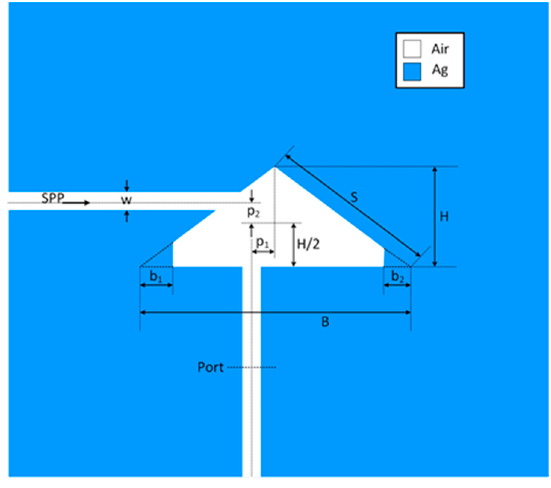
Figure 1. Layout of the proposed Fano MIM sensor with the corresponding geometrical parameters. Two MIM waveguides and triangular resonator are filled with air (marked in white) and surrounded with silver (marked in blue).